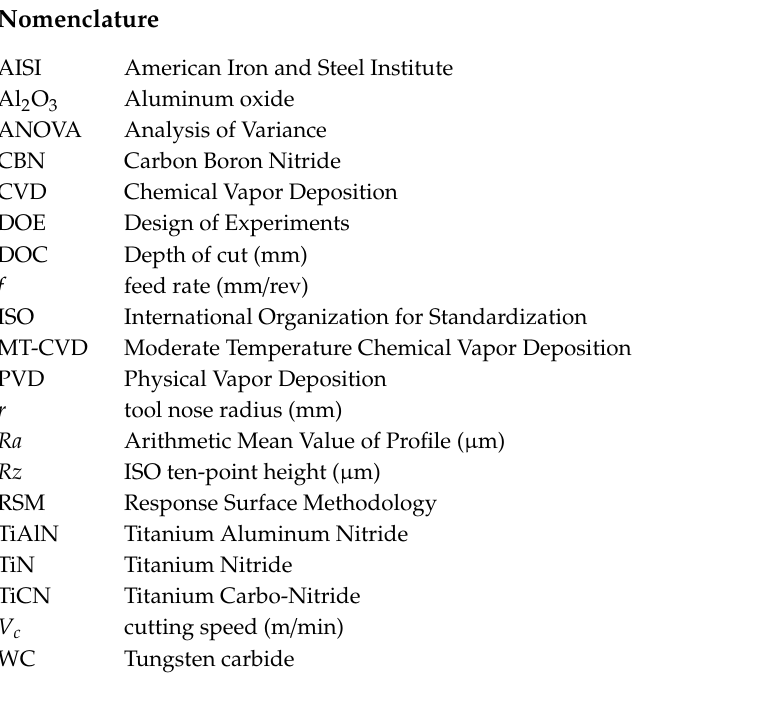
Figure S1: Main e ff ects plot for surface roughness means: (a) Ra ; (b) Rz; Figure S2: Graphs of the